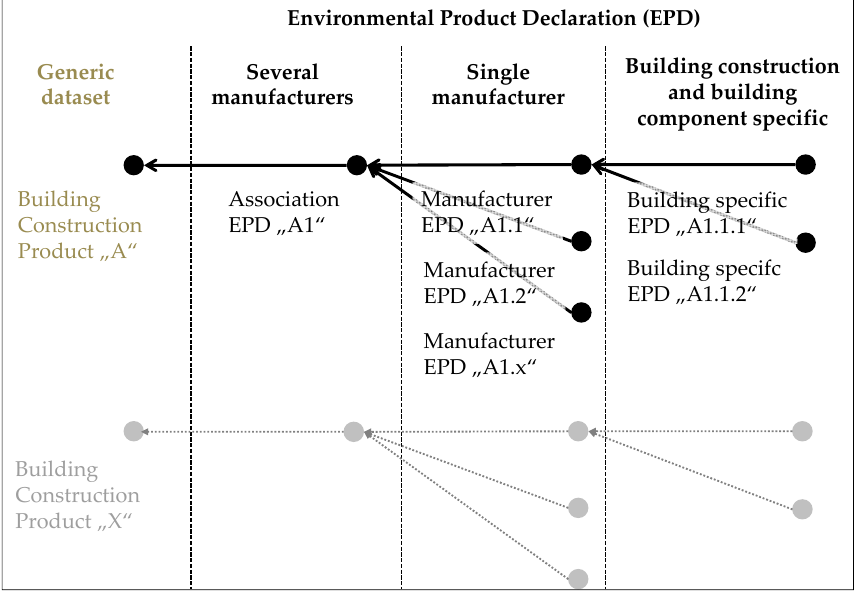
Figure 3. Structural approach to map life cycle assessment (LCA) data set types, ensuring the appropriate utilization and exchangeability of generic and specific data.